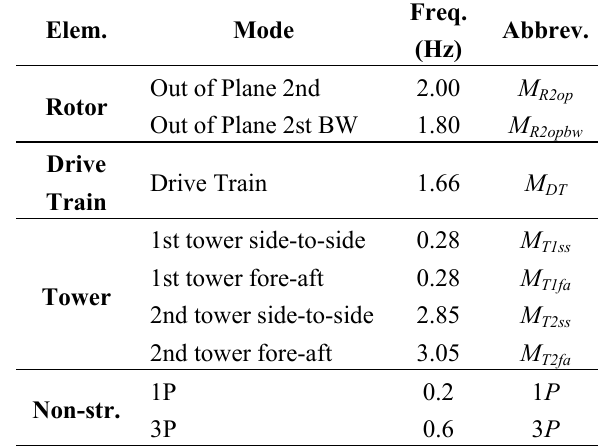
Table 1. Modal analysis of the Upwind model (BW: backward whirl; FW: forward whirl). Elem. Mode